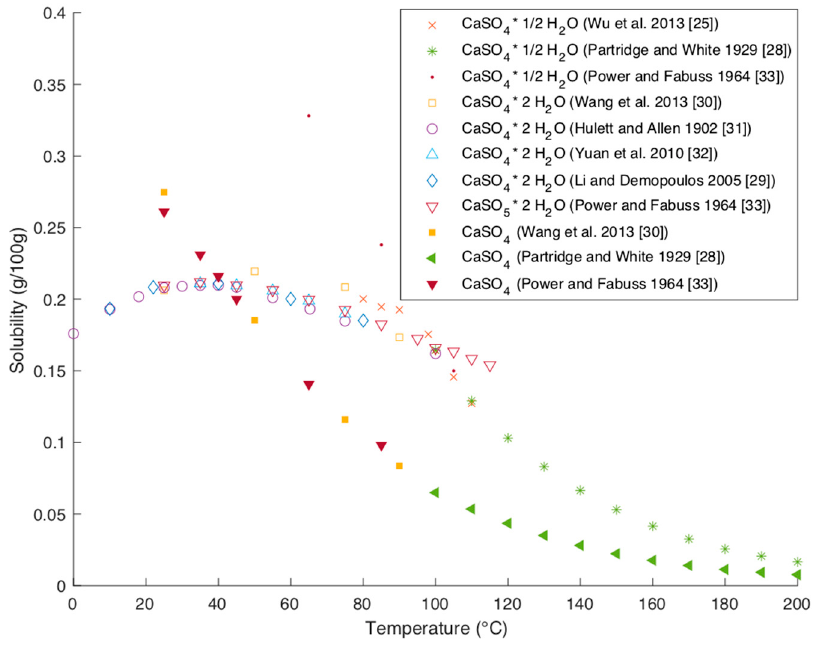
Figure 10. Solubility of CaSO 4 in water [25,28–33].